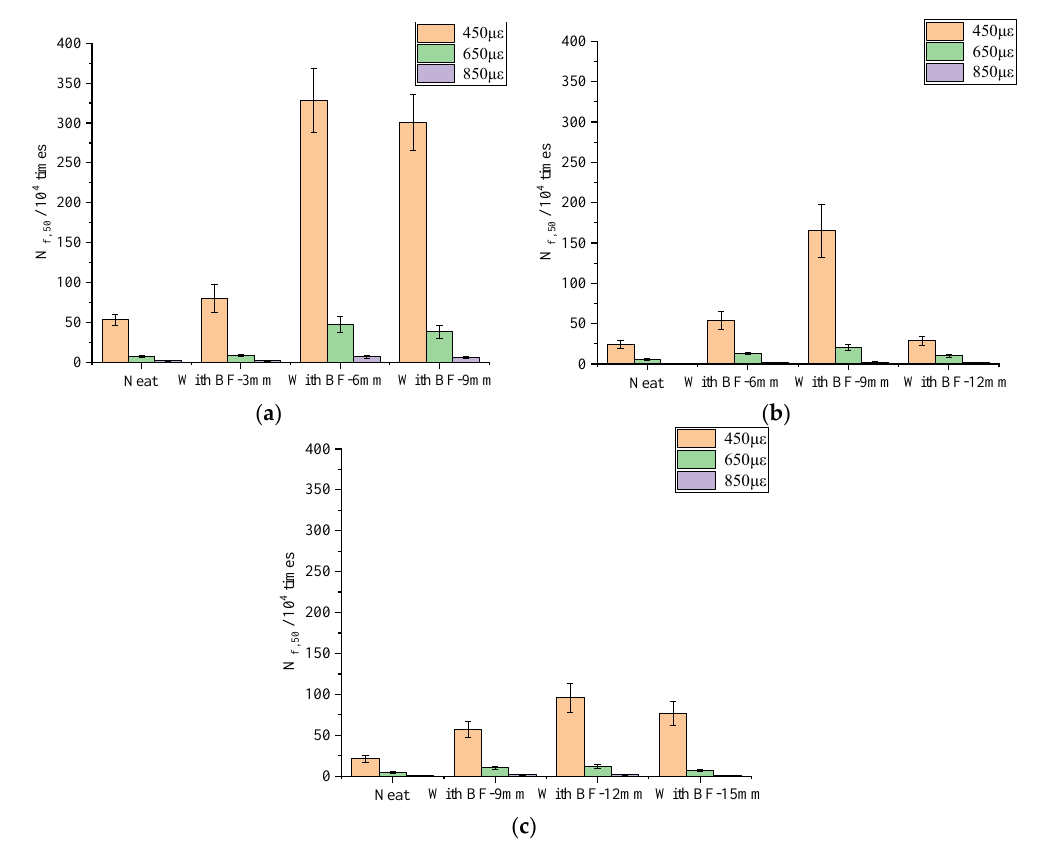
Figure 7. Four-point bending beam fatigue test results: ( a ) SUP-13; ( b ) SUP-20; and ( c ) SUP-25.